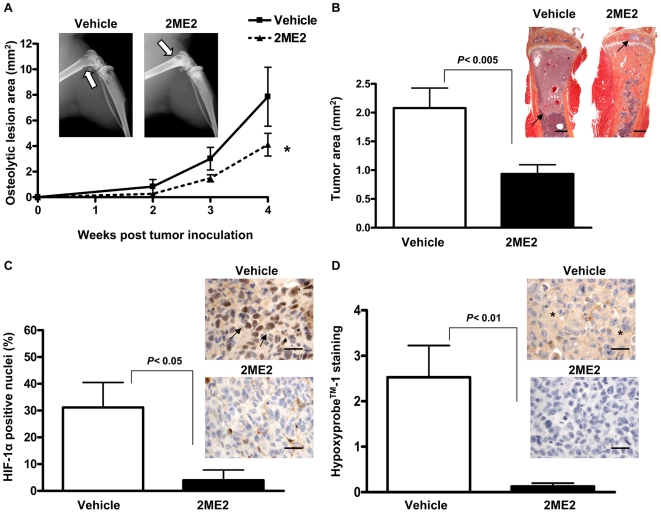
Preventive treatment with the HIF-1α inhibitor 2ME2 inhibits bone metastases in mice.(A) Representative 4-week x-rays from mice inoculated with MDA-MB-231 cells and treated ± 2ME2 (150 mg/kg), arrows indicate osteolytic lesions. Osteolytic lesion area was measured on radiographs of hindlimbs and forelimbs of mice with bone metastases. Results are expressed as the mean ± SEM area per mouse (n = 10–12 per group). * P<0.01 using a two-way ANOVA with a Bonferroni post-test at 4 weeks. (B) Representative histology of tibias with tumor indicated by arrows. Scale bar equal to 500 µm. Tumor burden in hindlimbs and humeri was measured by quantitative histomorphometry. Results are expressed as the mean ± SEM area per bone, analysis by unpaired Student's t test. (C) Representative HIF-1α staining in demineralized bone metastases sections from mice treated ± 2ME2. Arrows indicate HIF-1α positive nuclei. Scale bar equals 25 µm. The percentage of nuclei positive for HIF-1α was calculated in three non-overlapping fields at 400×magnification for each mouse (n = 6 per group). Results are the mean ± SEM number of HIF-1α positive nuclei per field using an unpaired Student's t test. (D) HypoxyprobeTM-1 staining for tumor hypoxia in bone metastases sections. Hypoxic regions indicated by asterisks. Staining was graded on a 1–4+ scale in three non-overlapping fields at 400×magnification per mouse (n = 3 per group). Results are the mean ± SEM staining per field using an unpaired Student's t test.